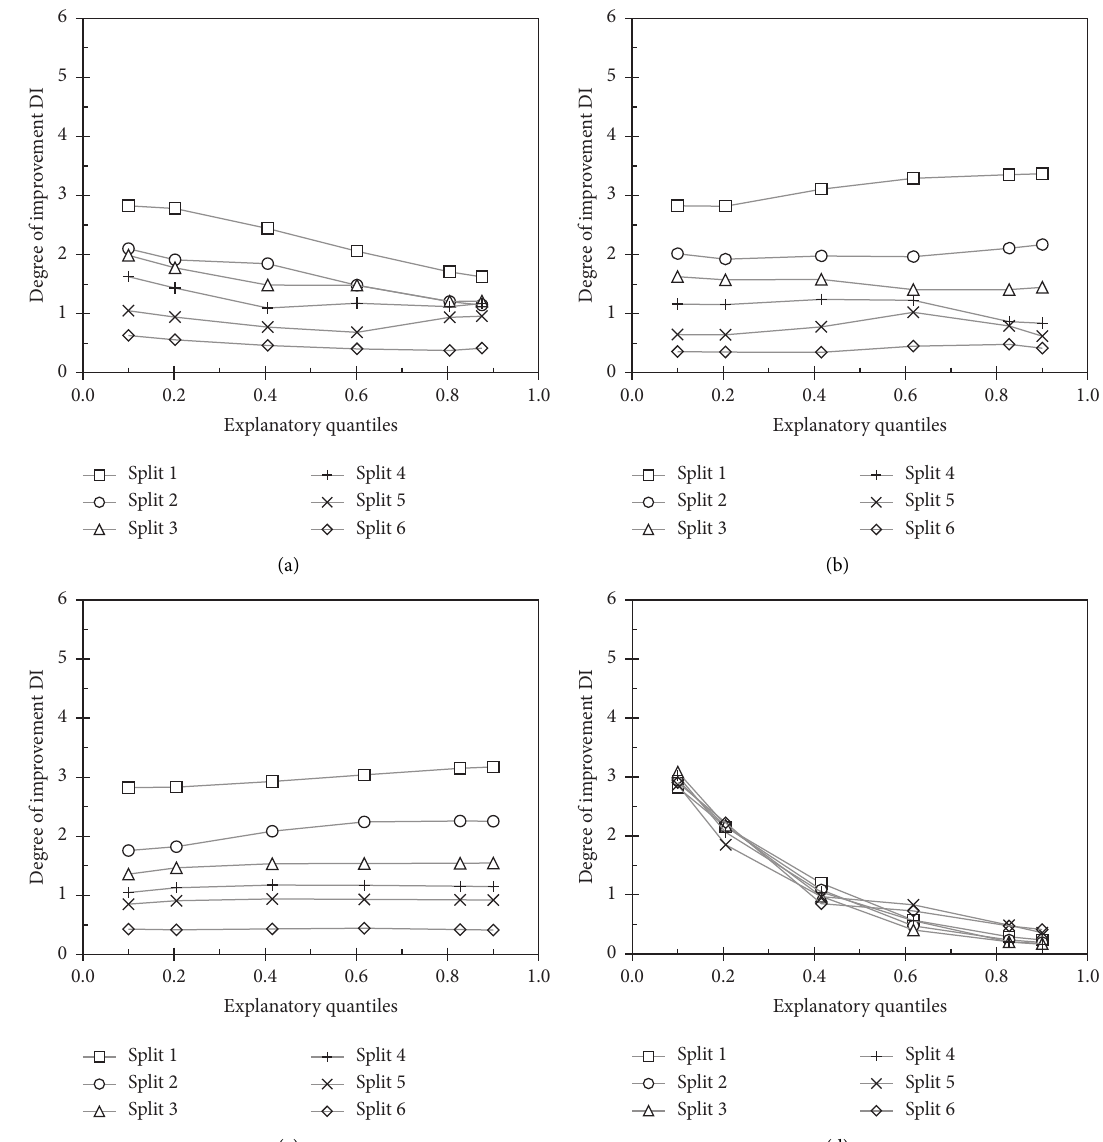
Figure 10: Sensitivity analyses of ANN model - Relationship between degree of improvement DI and explanatory variables. (a) X-co- ordinate, (b) Y-coordinate, (c) Applied energy (AE), and (d) Averaged SPT N value before dynamic